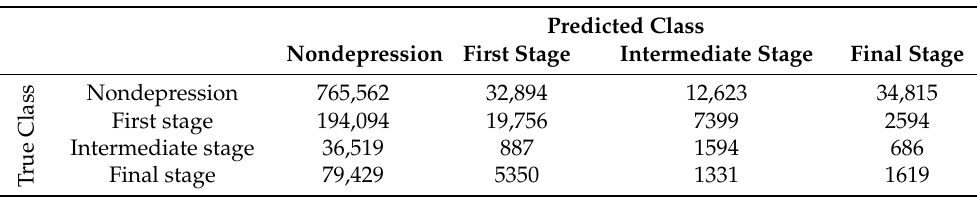
Table 11. An example of the confusion matrix obtained by the four-class classification in Setting